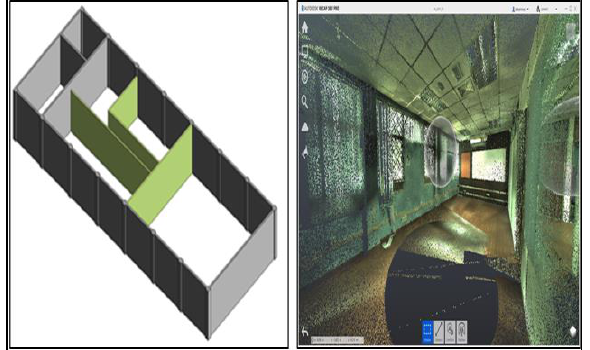
Figure 21. 3D model from TLS